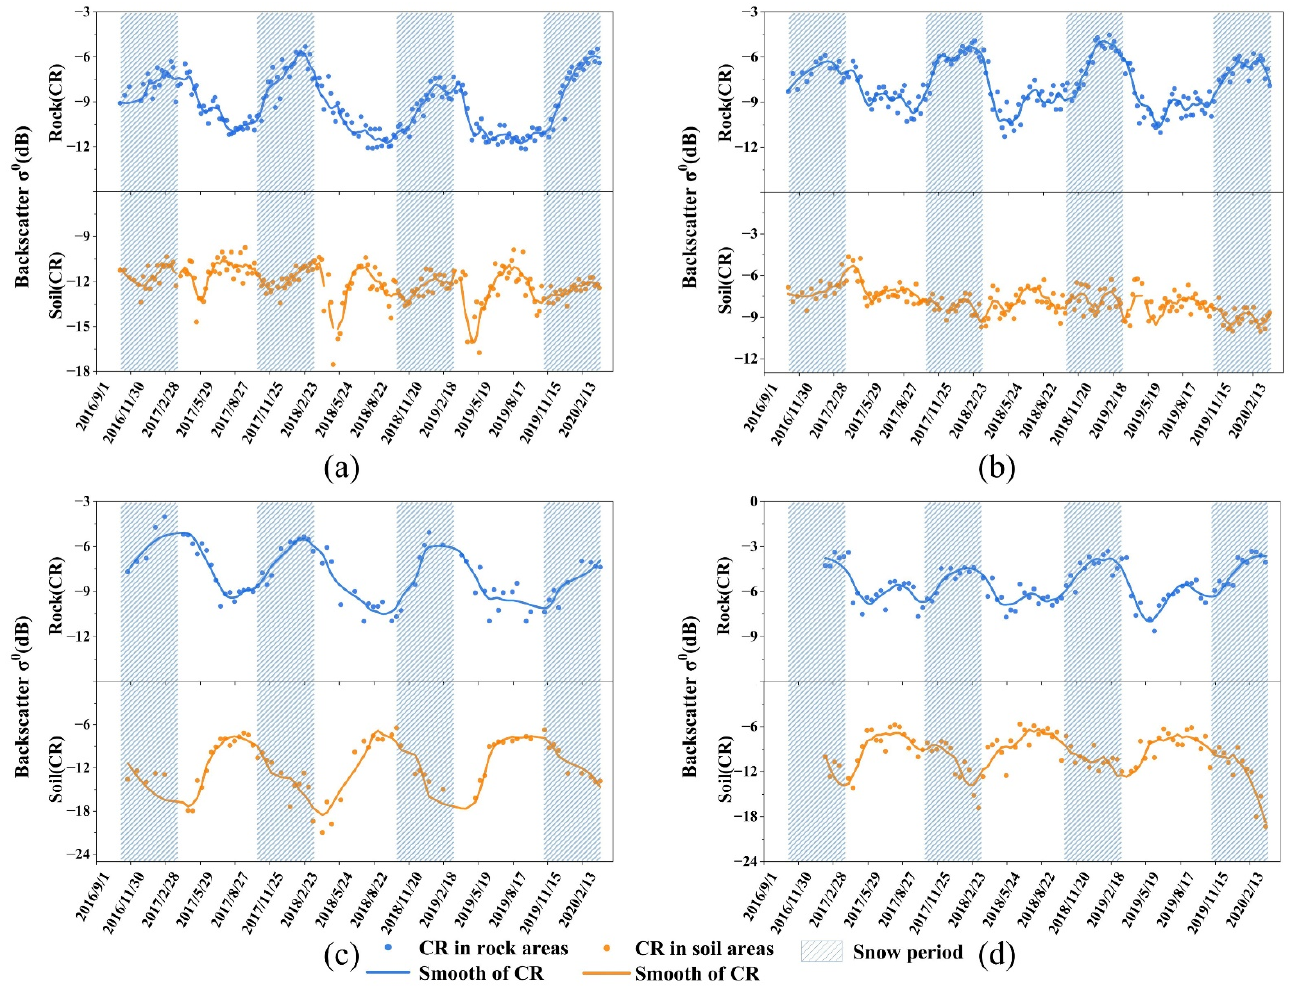
Figure 6. Time series of CR values for the two types of feature areas at the daily timescale during November 2016 to March 2020. Data smoothed by Satitzky-Golay filter (Points of Window is 10). ( a ) FV; ( b ) RS; ( c ) NK; ( d ) AP.